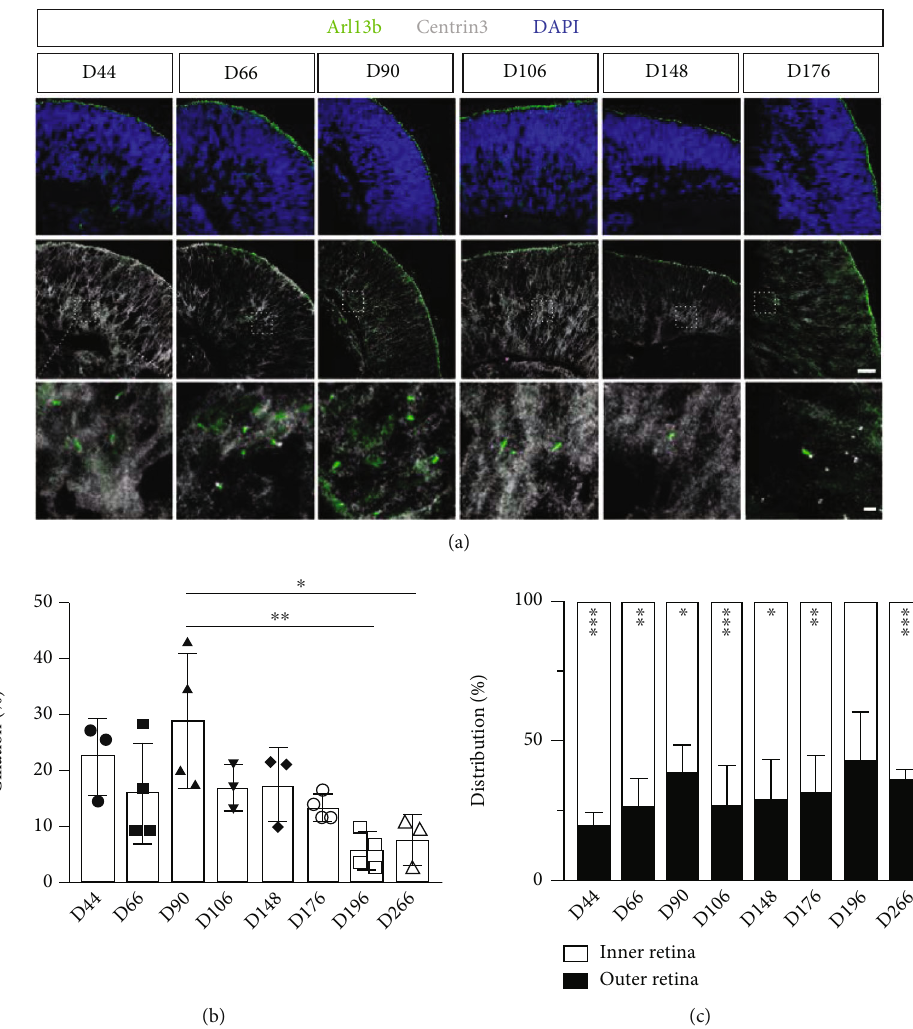
Figure 1: Primary cilia are expressed in the inner part of hESC-derived retinal organoids and their numbers decrease in later developmental stages. (a) Confocal images of retinal organoid sections from di ff erent developmental stages immunostained with two primary ciliary markers, Arl13b (green) and Centrin3 (gray) to reveal ciliary axoneme and basal body, respectively, (scale bar: 10 μ m; magni fi ed, 1 μ m). Nuclei are visualized by DAPI (blue). (b) Quantitative analyses reveals that the ciliation (the number of cells expressing primary cilia) of retinal organoids is at its peak at day 90 and signi fi cantly declines at day 196 and day 266 ( ∗∗ P = 0 : 003 and ∗ P = 0 : 014 , One-way ANOVA). (c) Quanti fi cation of the percentage of ciliated retinal cells distributed in the outer and inner sides of retinal organoids.